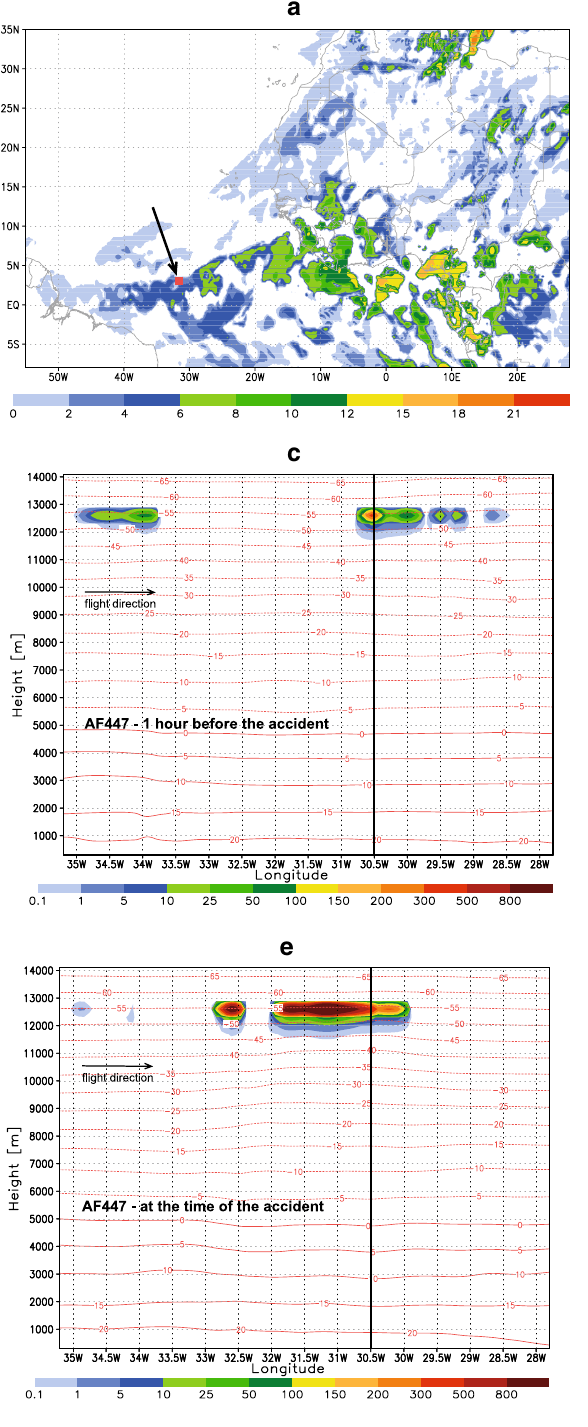
Figure 3. Cloud icing conditions for AF477 (left column) and AH5017 (right column). Arrows, crosses and thick lines above indicate locations of the accident. ( A , B ) Predicted vertically integrated log 10 ( n INP ) at the times of accidents. ( C – H ) Height-time graphs of the predicted Dust Icing Index DII for three consecutive times around the instances of the